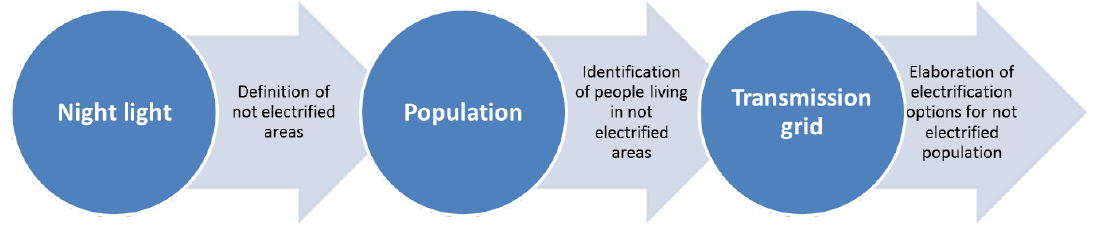
Figure 1. Datasets applied in this research for identifying geospatially resolved electrification options.